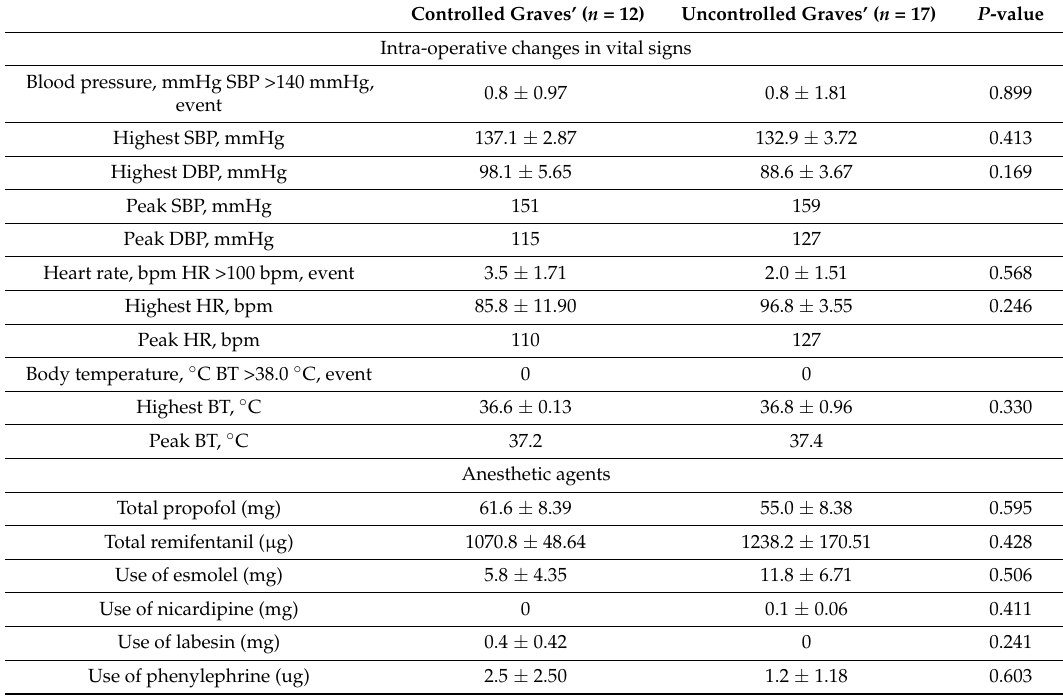
Table 2. Intra-operative changes in vital signs and use of anesthetic agents in patients with controlled and uncontrolled Graves’ disease.